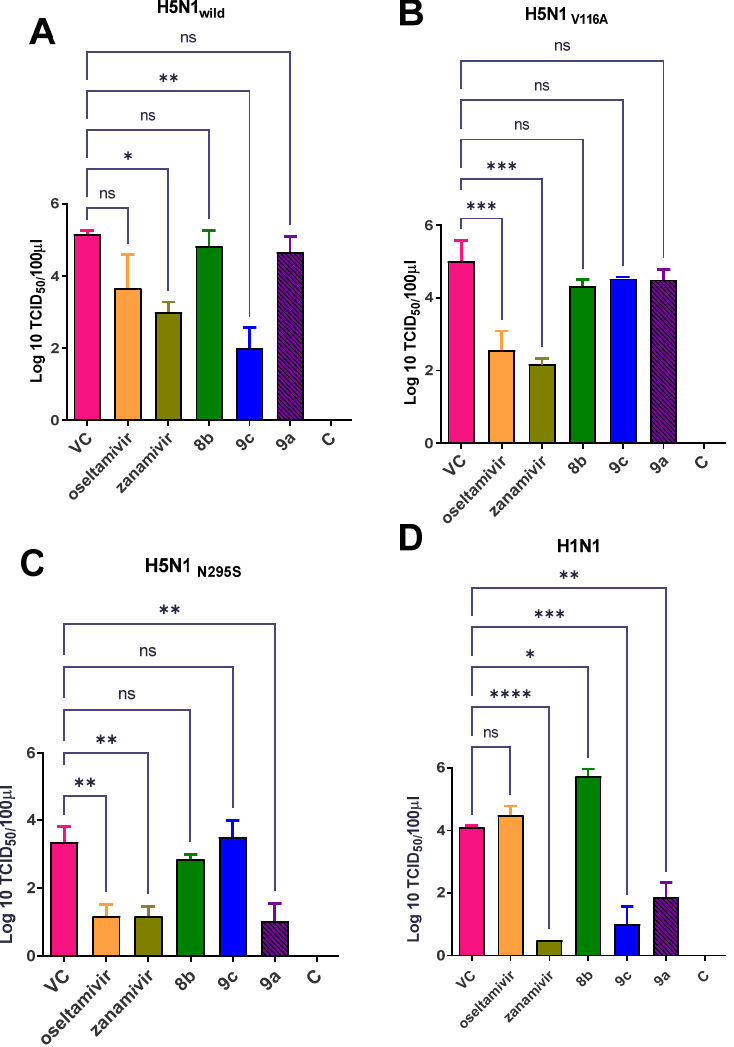
Figure 10. TCID 50 titration of lung tissue after 3 DPI. ( A ) 9c was the most promising synthetic compound after infection with H5N1 wild and reduced the propagation of the virus more than oseltamivir and zanamivir. ( B ) Oseltamivir and zanamivir reduced the propagation of the virus more than synthetic compounds after infection with H5N1V116A. ( C ) 9a, oseltamivir, and zanamivir similarly reduced the propagation of the virus after infection with H5N1N295S. ( D ) 9c and 9a reduced the propagation of the virus after infection with H1N1 as much as zanamivir, but oseltamivir did not affect the propagation of the virus in the lung. The significant differences are indicated as follows: * p < 0.05, ** p < 0.01, *** p < 0.001, **** p < 0.0001, and ns = non-significant.